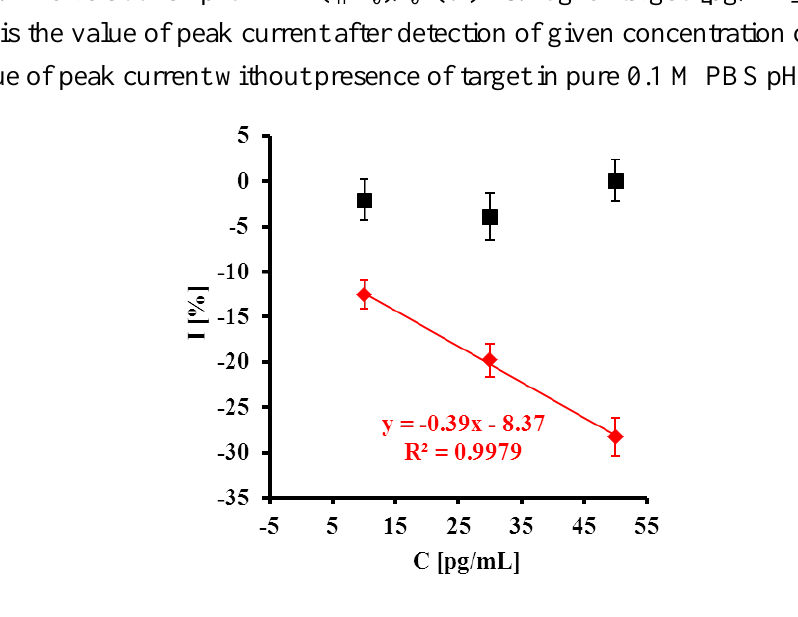
–I )/I (%) vs. log C target [pg/mL] of (♦) C + and n 0 0